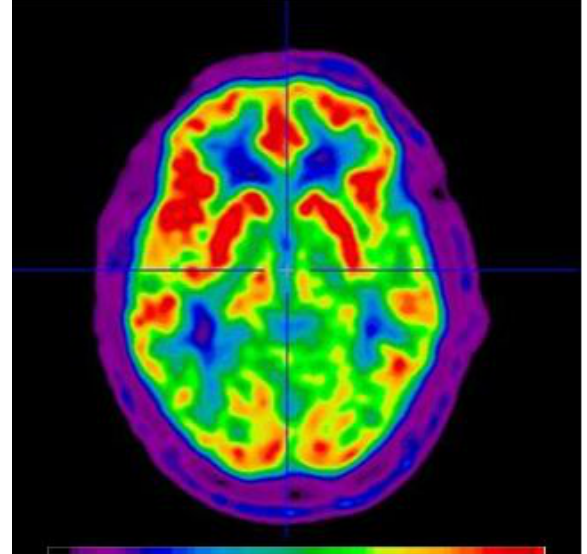
Figure 3. An example of [ 15 O]Water Positron Emission Tomography (PET). The image is scaled in activity units (kBq/cc). The image was created by summing the first 40 seconds immediately post-bolus transit from a dynamic imaging sequence initiated at the time of [ 15 O]water injection. The image is a semi-quantitative representation of the cerebral blood flow (CBF) at the time of bolus arrival in the brain. The color bar describes increasing blood flow with increasing signal intensity (from black to red).